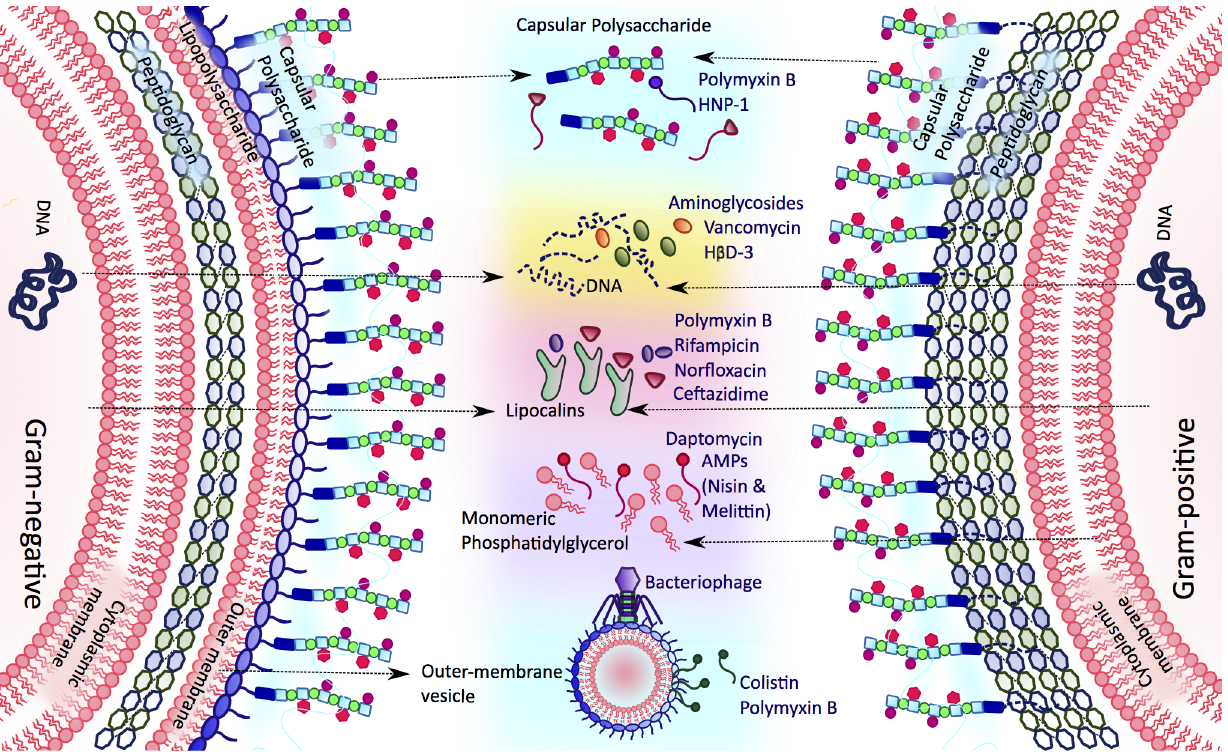
Fig 1. Bacteria release a diverse array of molecules to intercept antibiotics. AMP, antimicrobial peptide; HNP-1, human neutrophil protein-1; H β D-3, human β -defensin 3.